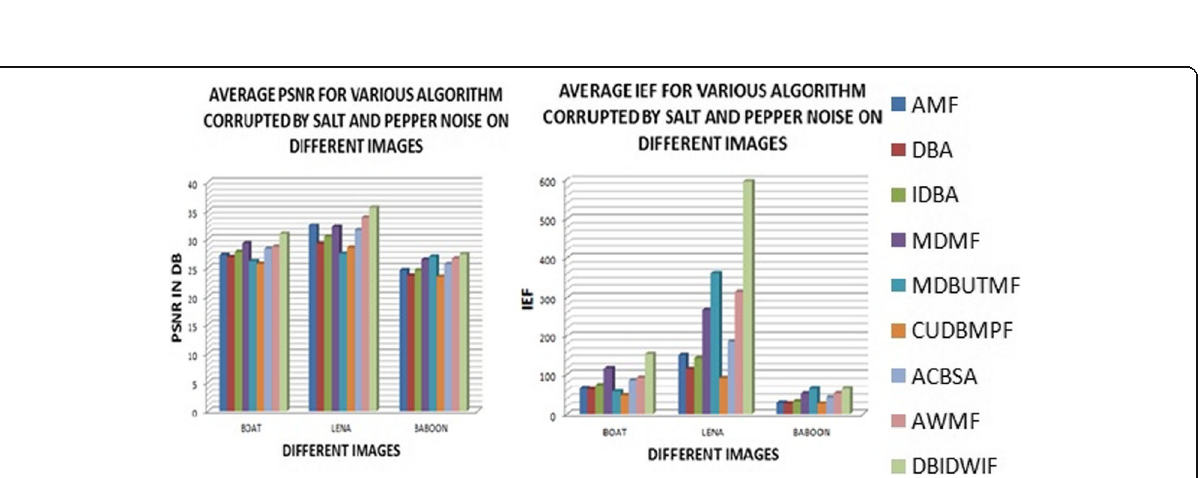
Fig. 13 Average PSNR and IEF for various algorithm corrupted by salt and pepper noise on different images